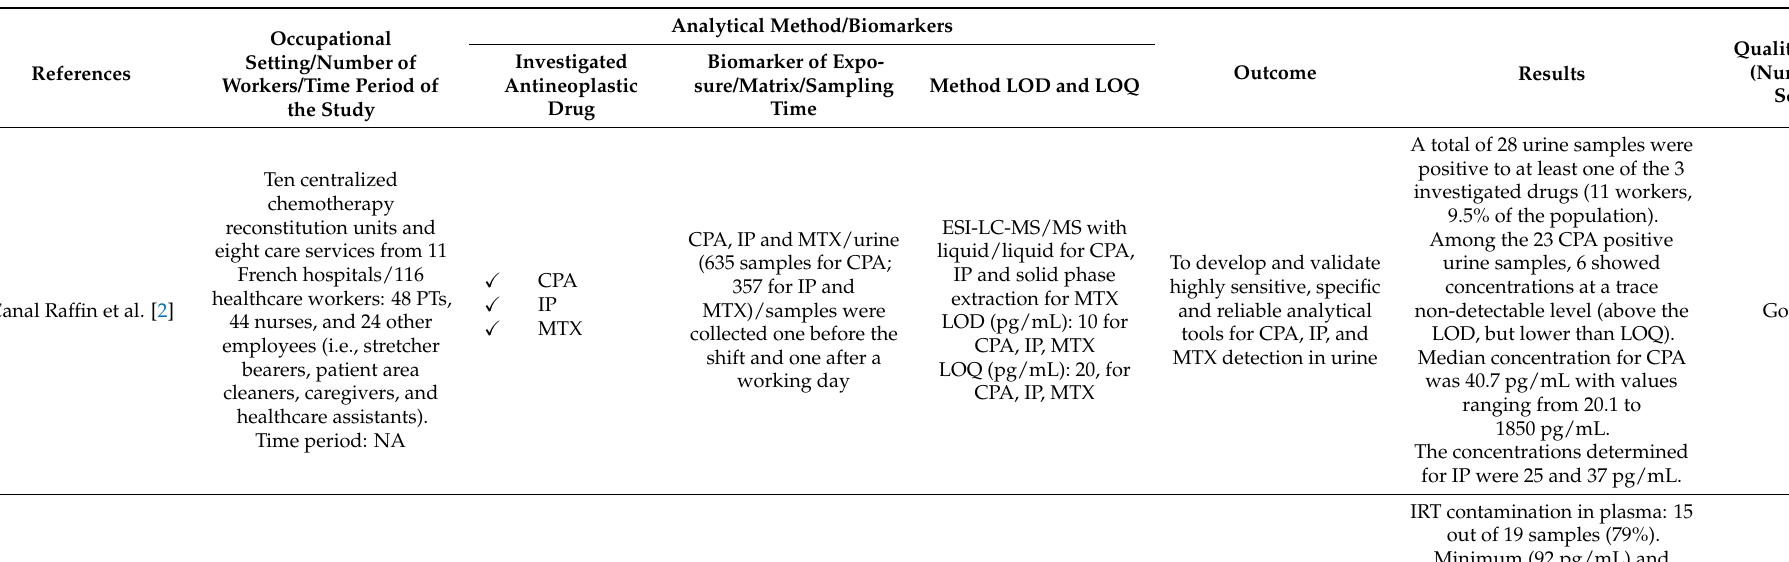
Table 1. Studies assessing occupational exposure to ADs through biological